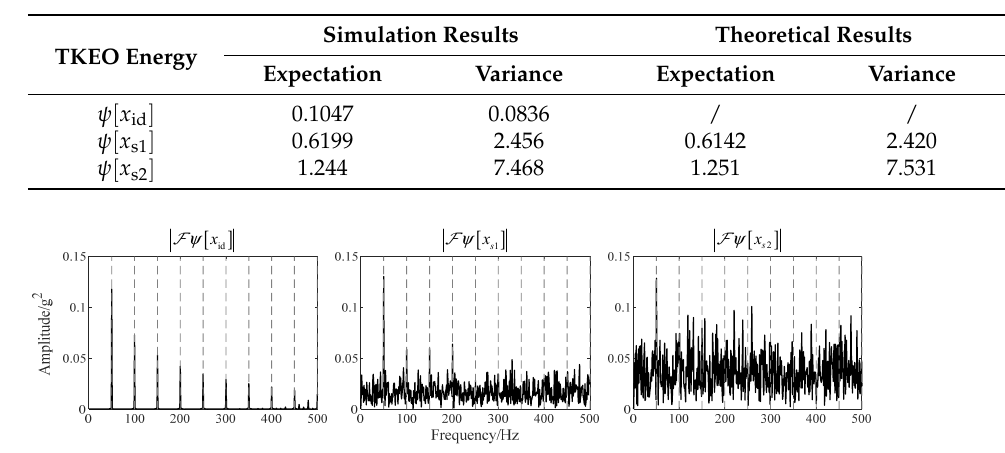
Figure 2. The TKEO energy spectra of id x , s1 x and s2 x .